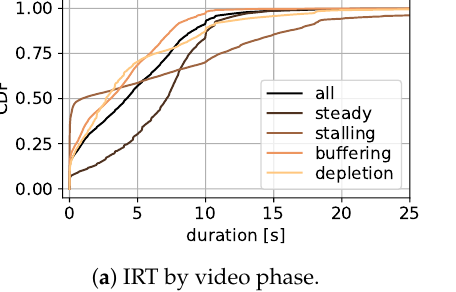
Figure A6. Dataset overview: stalling and video phase.